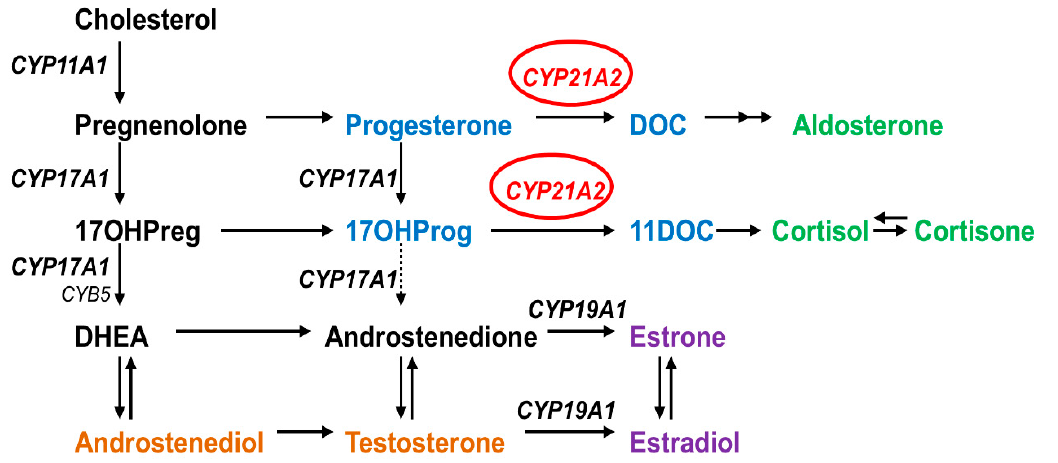
Figure 1. Role of CYP21A2 in human steroid biosynthesis. CYP21A2 is a heme containing cytochrome P450 protein that requires cytochrome P450 reductase as a redox partner for its metabolic reactions [6]. Together with CYP11A1 in mitochondria and CYP17A1 and CYP19A1 in the endoplasmic reticulum, CYP21A2 directs the biosynthesis of steroids.